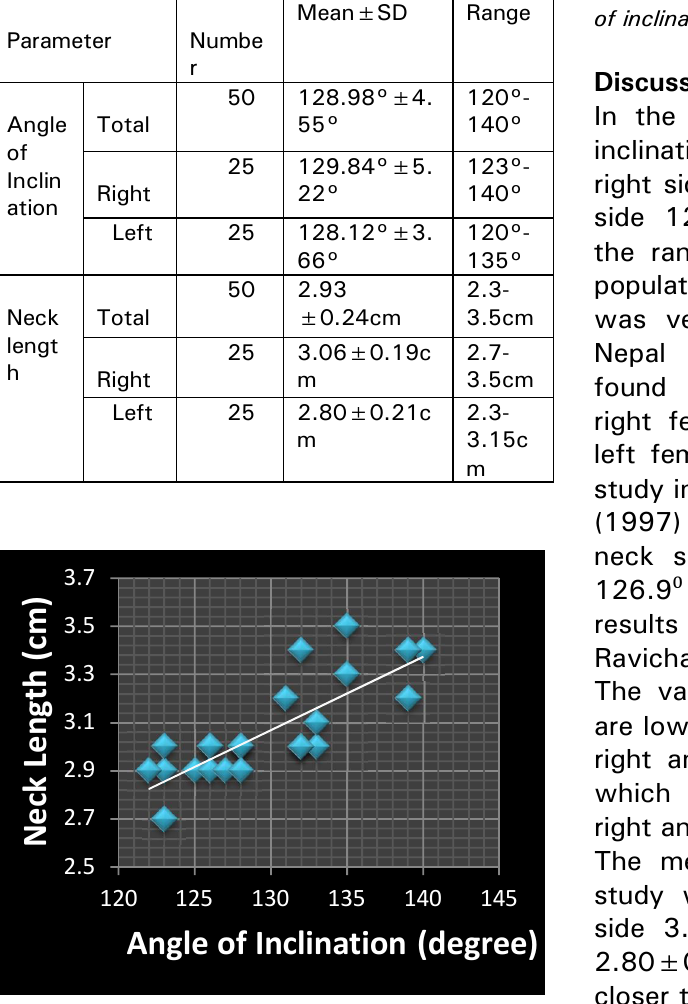
Graph 2: Correlation between left side Angle of inclination and neck length of femur: increased angle of inclination with increase in neck